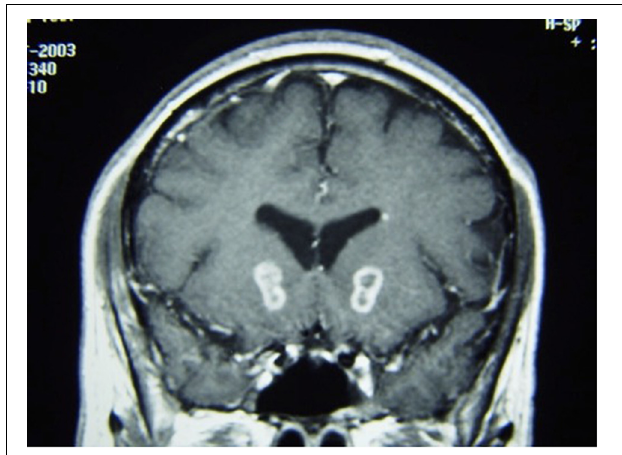
FIGURE 8 | Coronal T1-weighted MRI with contrast of gamma knife capsulotomy lesions.